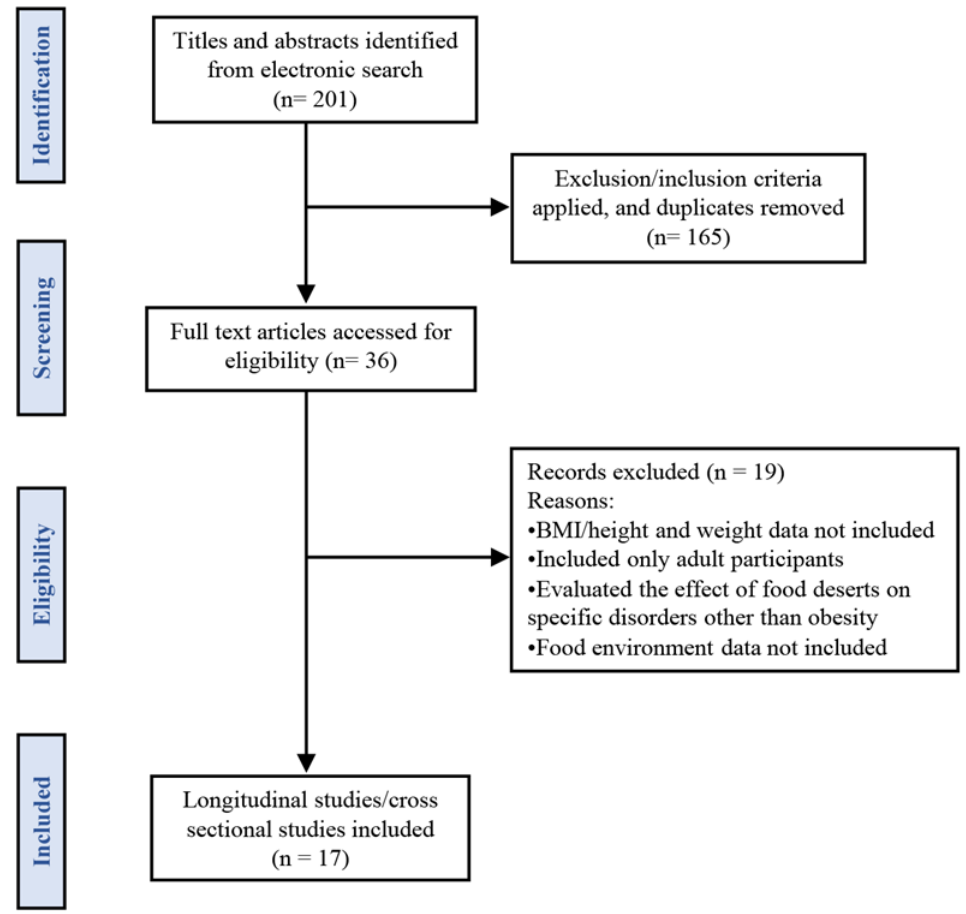
Figure 1. Flow chart for the article selection process.